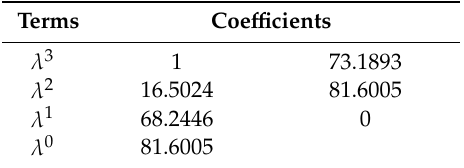
Table 2. The Routh array with k 1 = 1, k 2 = 5, k 3 =